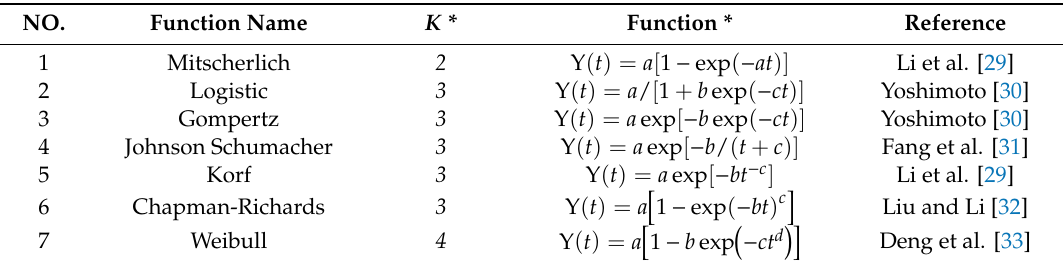
Table 1. Seven theoretical functions used to fit the diameter at breast height ( DBH ), tree height ( H ), and tree volume growth in the